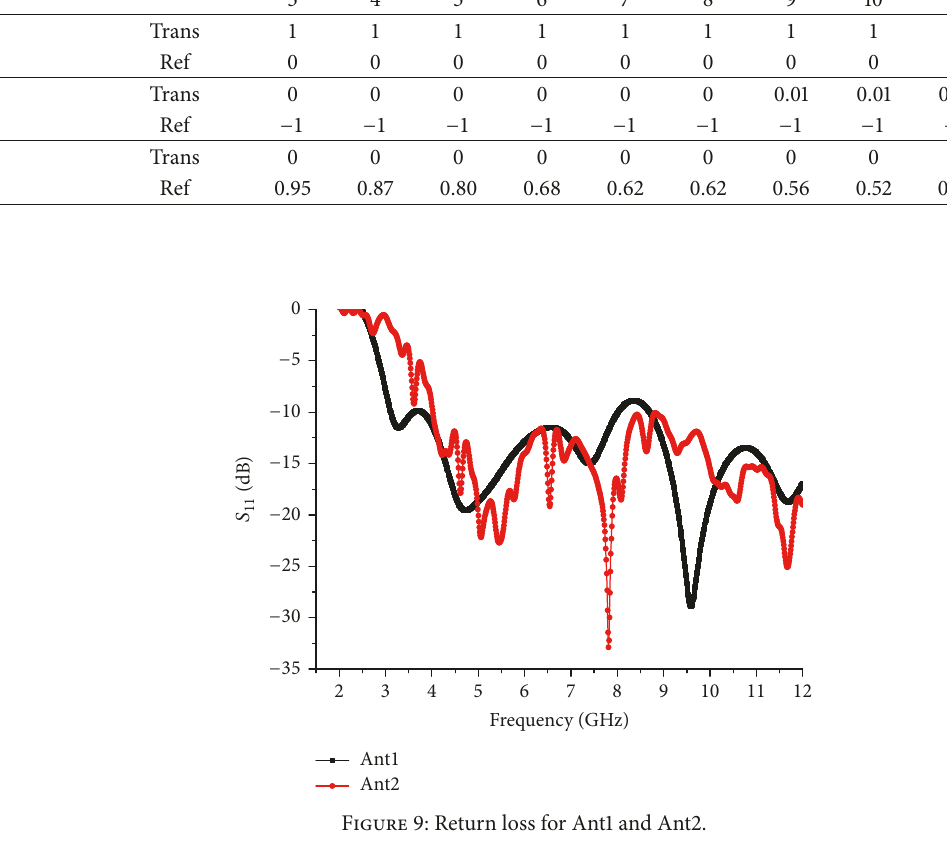
Table 1: Total reflected and transmitted wave power flow for different structure (normalization value). Analyzed structures